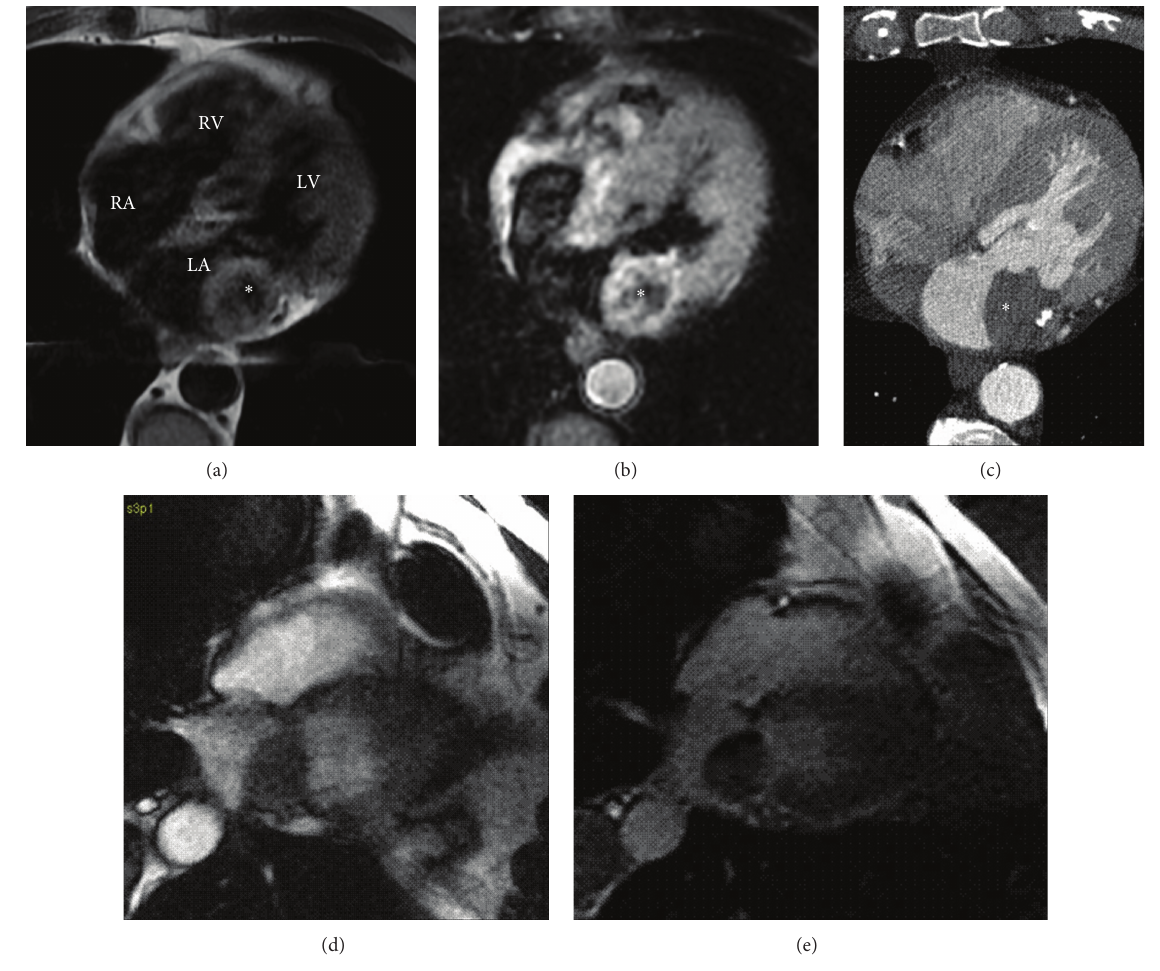
Figure 2: Axial (a) MRI T1- and (b) T2-weighted and (c) CT contrast enhanced imaging and 4-chamber MRI (d) first pass perfusion and (e) late gadolinium enhancement (TI = 350 ms) imaging. MRI T1- and T2-weighted black blood images demonstrate a lobulated mass (asterisk) with central signal drop-out suggestive of punctuate calcification confirmed by CT. CT imaging also suggests that this mass is contiguous with the posterior leaflet of the mitral valve. Dynamic contrast-enhanced MRI demonstrates very minimal first pass perfusion and heterogenous late enhancement consistent with surface thrombus overlying a tumour. (RA) right atrium, (LA) left atrium, (RV) right ventricle, and (LV) left ventricle.